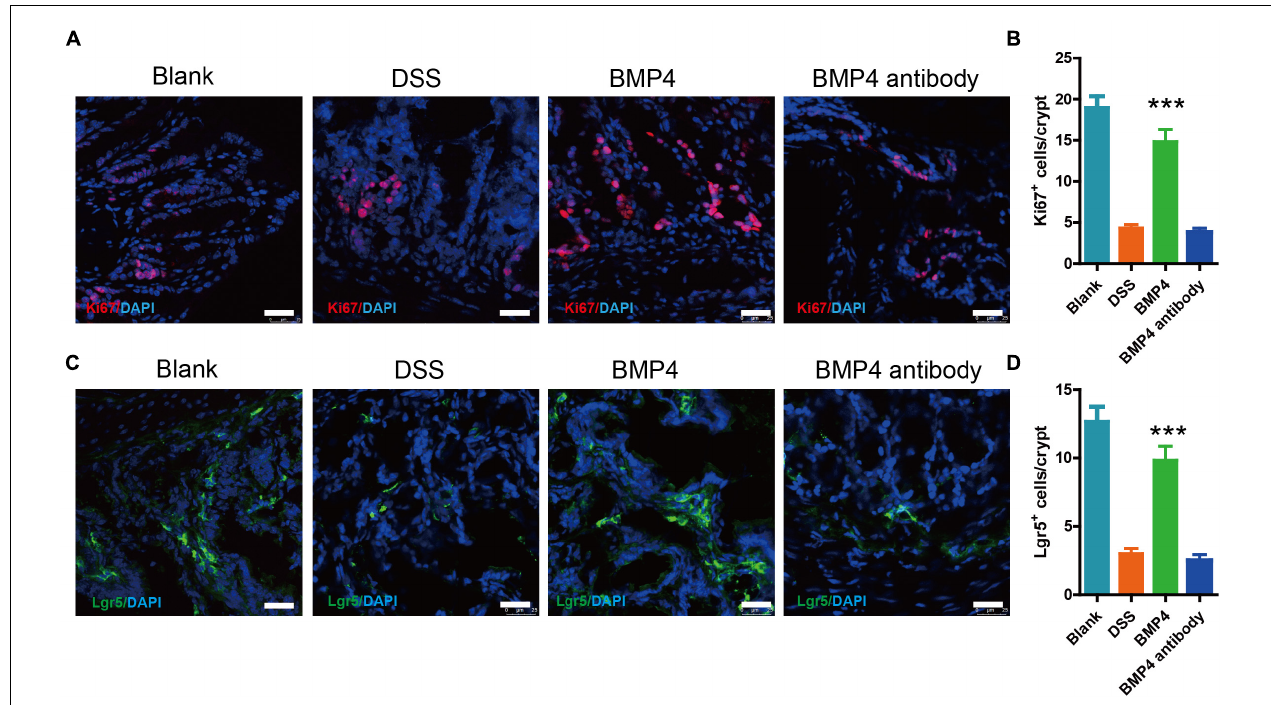
FIGURE 5 | BMP4 maintains epithelium cell proliferation and Lgr5 + ISCs following DSS-induced injury. (A) Immunofluorescence staining for Ki67 in colon tissue from DSS-induced mice treated with saline, BMP4, or anti-BMP4 antibody (red: Ki67, blue: DAPI). (B) Quantification of Ki67-positive cells per crypt ( n = 5). (C) Immunofluorescence staining for Lgr5 in colon tissue from DSS-induced mice treated with saline, BMP4, or anti-BMP4 antibody (green: Lgr5, blue: DAPI). (D) Quantification of Lgr5-positive cells per crypt ( n = 5). Data represent mean ± SD with three independent experiments. One-way ANOVA and Bonferroni tests for multiple testing were applied in all cases. *** p < 0.001. Scale bar = 25 µ